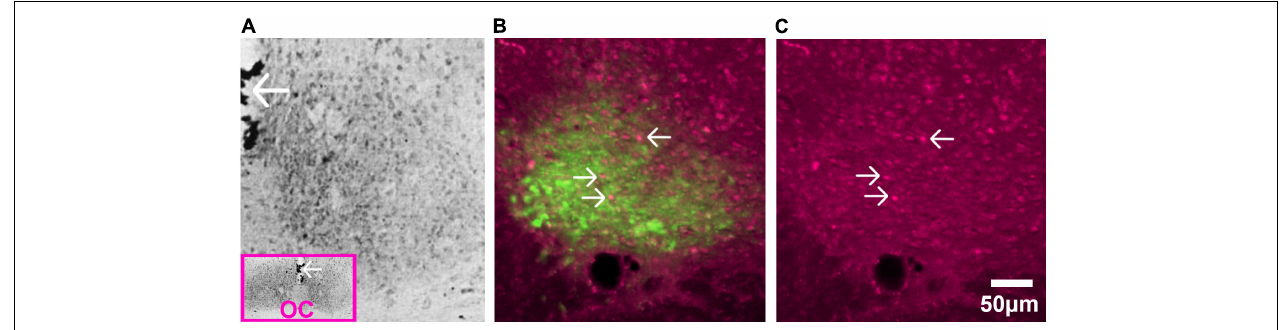
FIGURE 6 | Glucocorticoid receptors in SCN of adult rat. (A) Immunostaining of GR detected by avidin-biotin-peroxidase complex in the adult rat. The pink box in the inset is a low magnification image of the section and the arrows pointing to the third ventricle provide orientation. Abbreviation: optic chiasm (OC). Image adapted from Rosenfeld et al. (1988), with permission from Elsevier. (B) AVP staining identifies the shell region of the SCN. Image shows fluorescent double label for GR (magenta) and AVP (green) in the adult rat SCN. (C) Single label fluorescent stain for GR alone is shown in (C) . In both (B,C) , arrows point to GR expressing